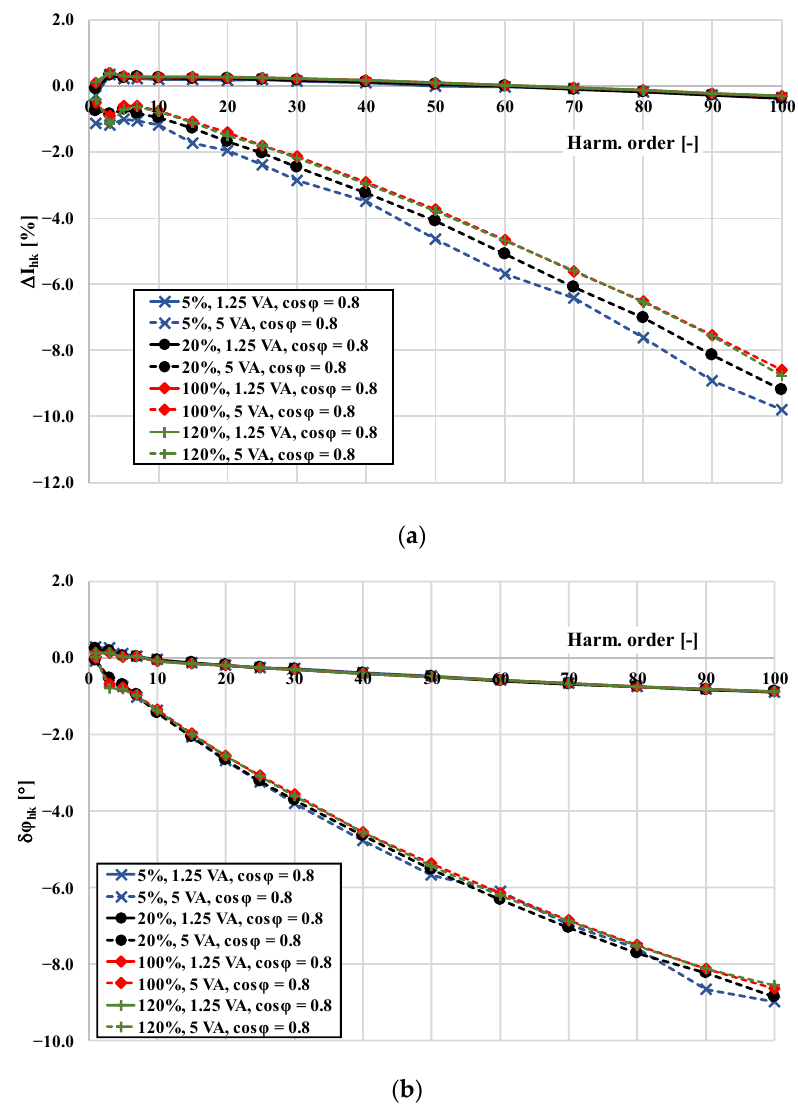
Figure 3. Influence of the secondary winding load with power factor 0.8 inductive of a 300 A/5 A CT on its transformation accuracy: ( a ) current error; ( b ) phase displacement.